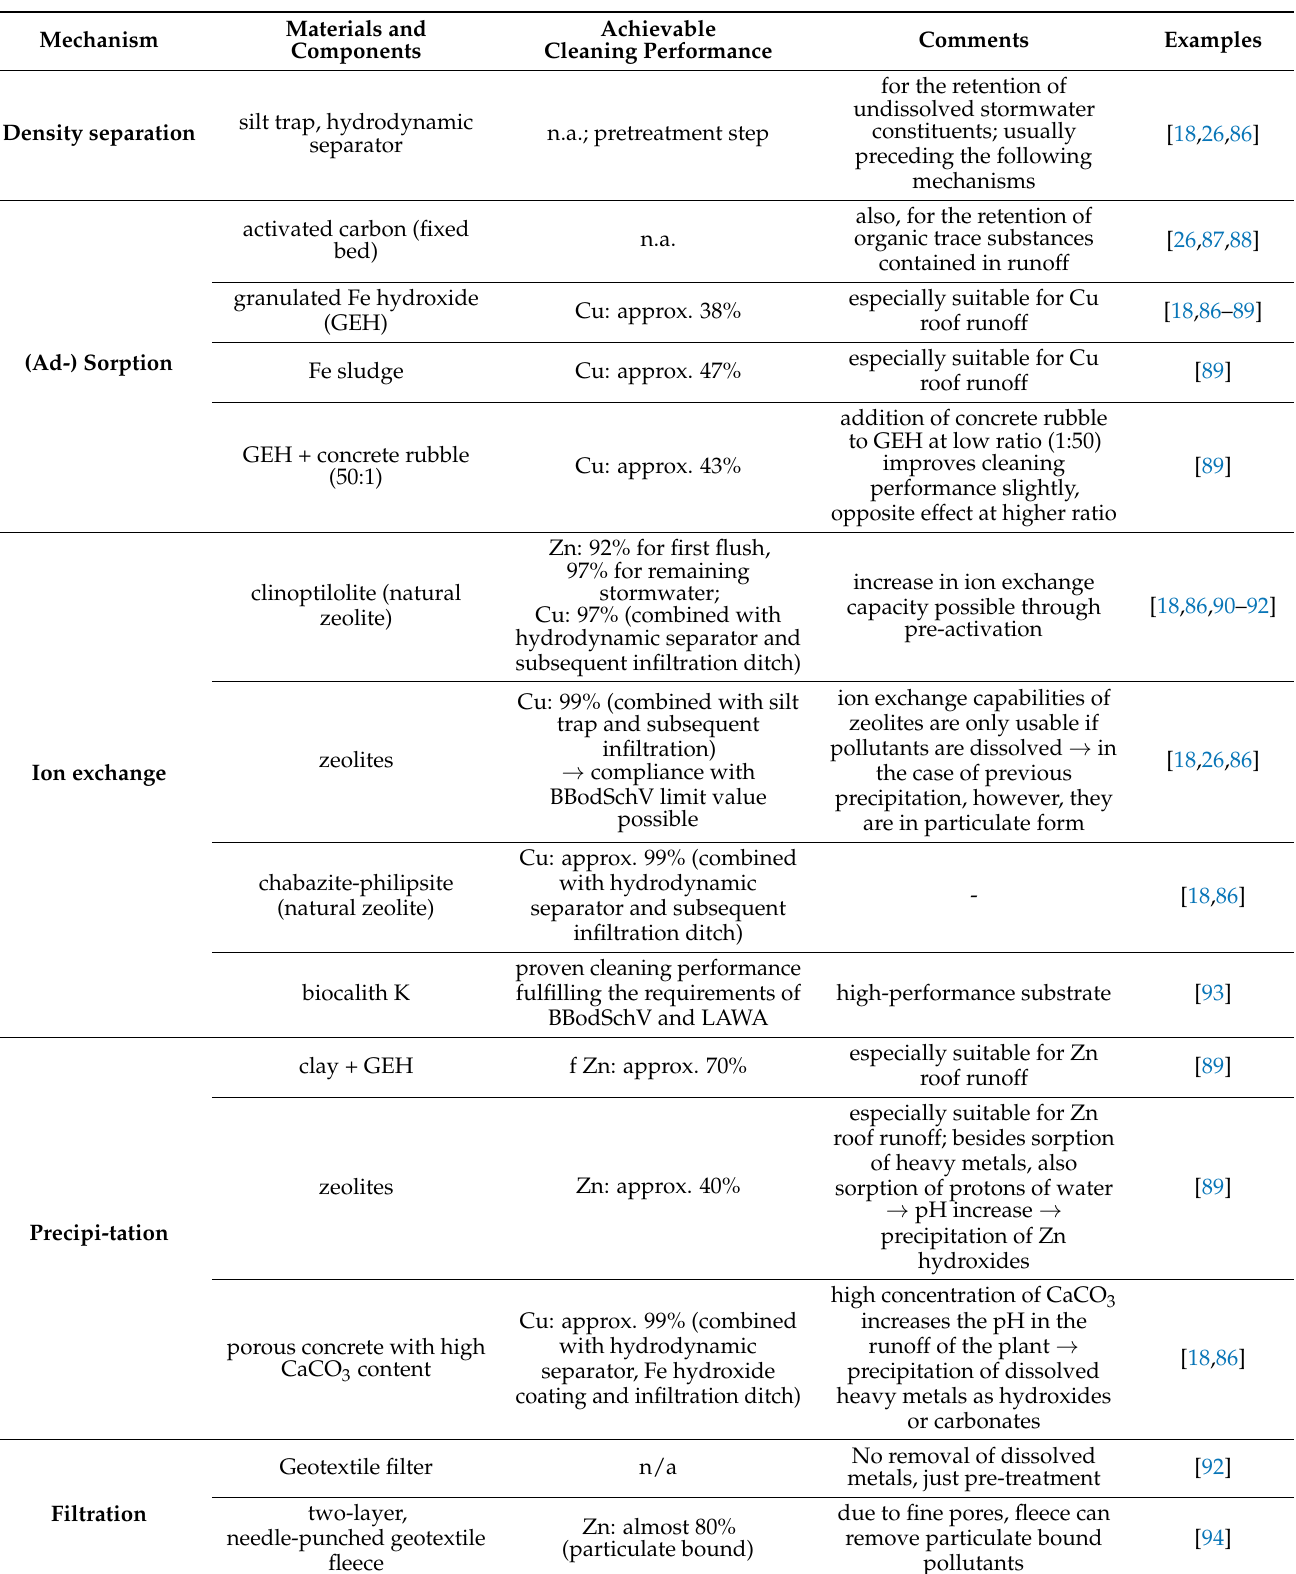
Table 3. Overview of mechanisms and components to remove Cu and Zn from runoff. (data according to